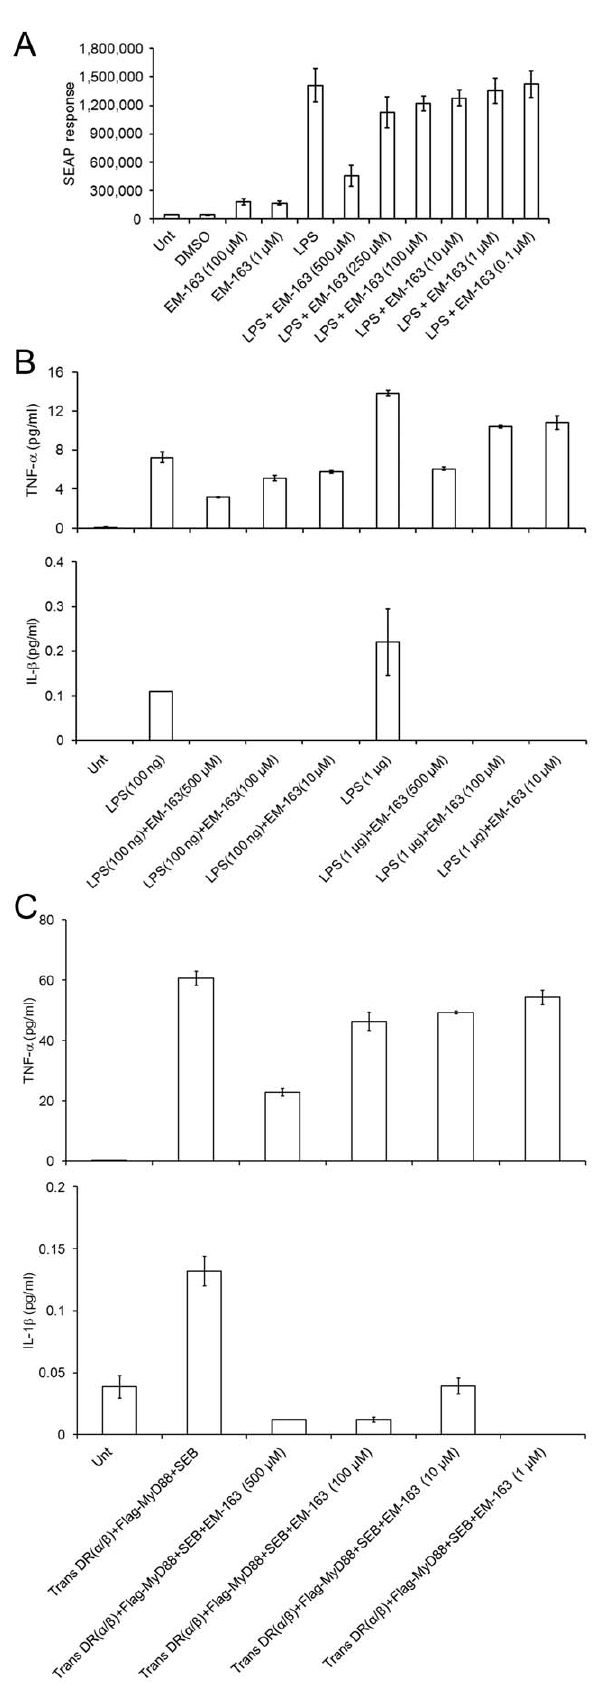
Figure 6. EM-163 inhibits MyD88-mediated signaling and cytokine production. EM-163 inhibition was measured by monitoring LPS-induced SEAP activity via a MyD88-mediated NF-kB driven signaling pathway. HEK 293 stable transfected cell line (TLR4-MD2-NF-kB-SEAP) was activated with LPS (TLR-4 ligand) and treated with varying concentrations of EM-163 (1 mM to 50 m M). Culture supernatants were tested for SEAP activity and compared to levels in the absence of EM- 163. ( A ) Inhibition of SEAP reporter activity, ( B ) inhibition of TNF- a and IL-1 b production, ( C ) Inhibition of TNF- a and IL-1 b production by EM- 163 after SEB stimulation of HEK 293 cells transfected with HLA-DR ( a / b ) and FLAG-MyD88. Results represent three experiments.